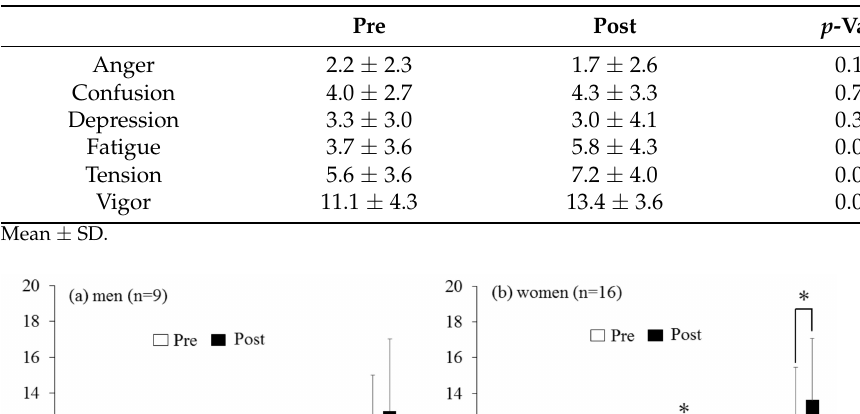
Table 1. Changes in POMS score ( n = 25).